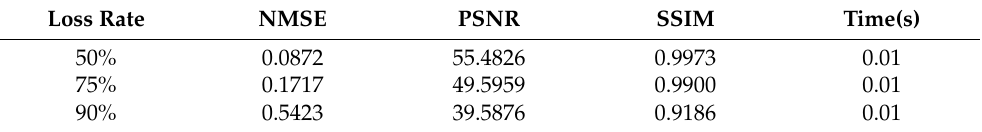
Table 9. Performance evaluation for the simulated data with different loss rates under the 15 dB condition.